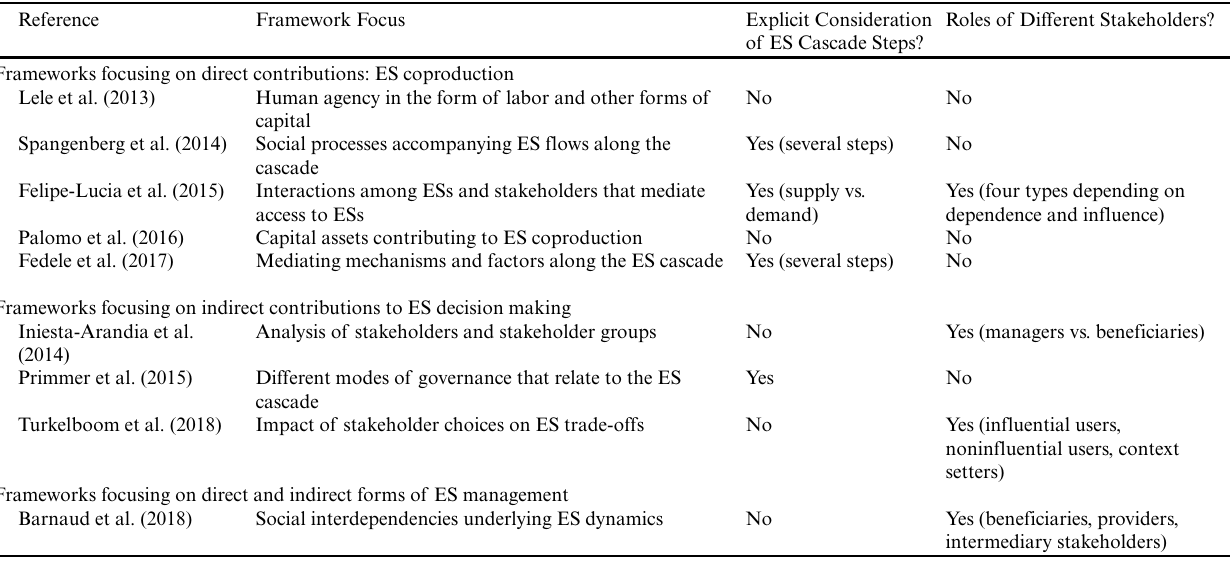
Table 1 . Comparison of existing ecosystem service (ES) management frameworks. We distinguish between direct and indirect ES